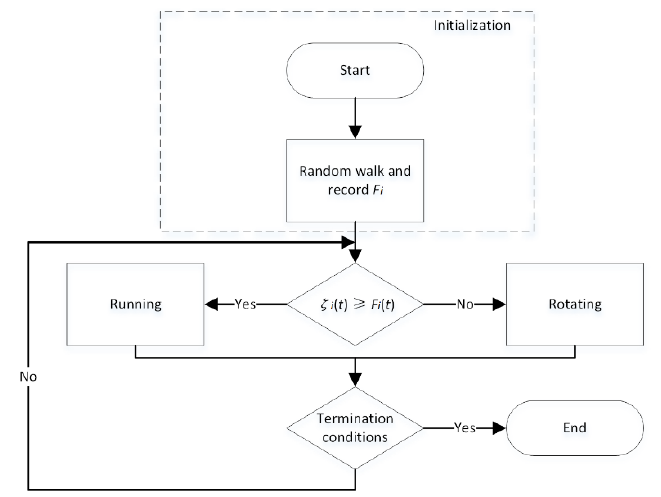
Figure 9. Flowchart of BCCS for aggregation.